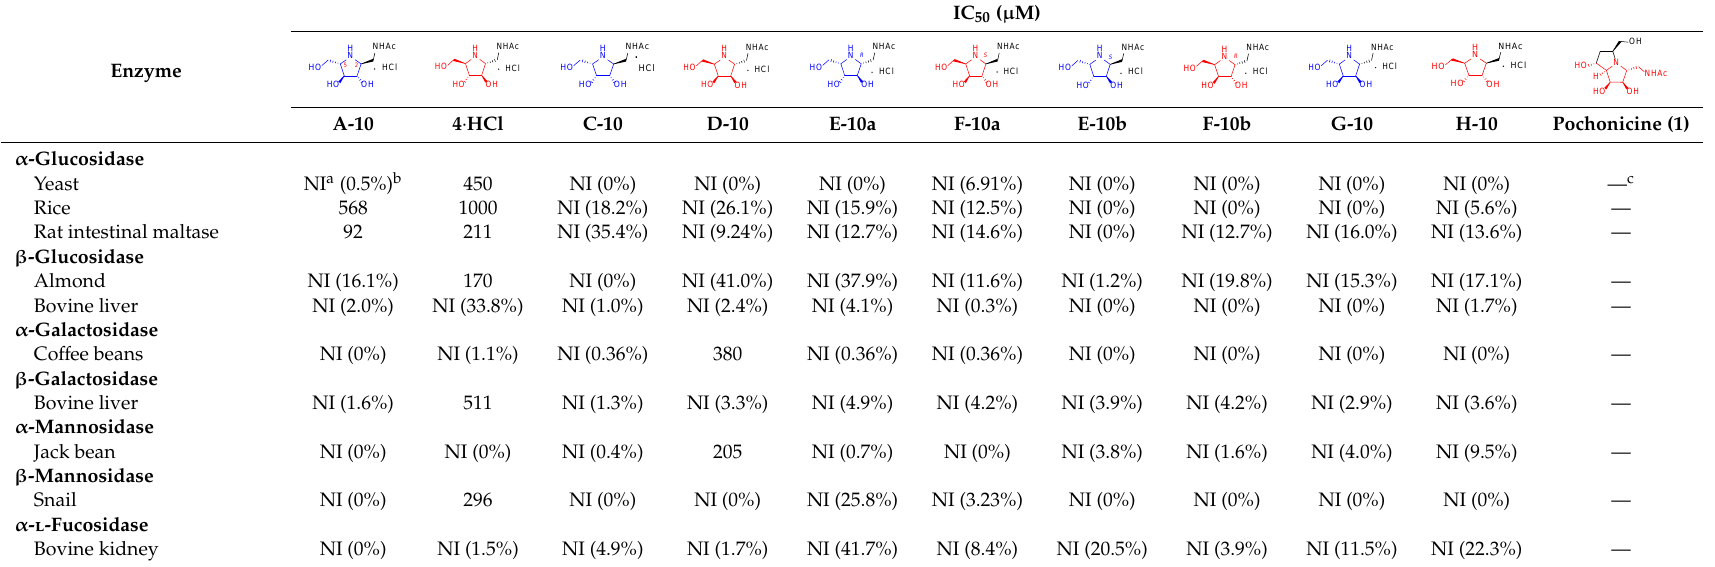
Most of them showed weak or no inhibition of all the glycosidases tested. As an exception, com-